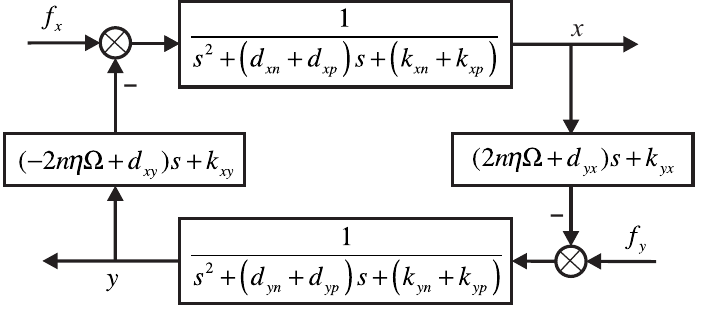
Figure 12. The Bode plot of the small signal extracting system in the driving components.